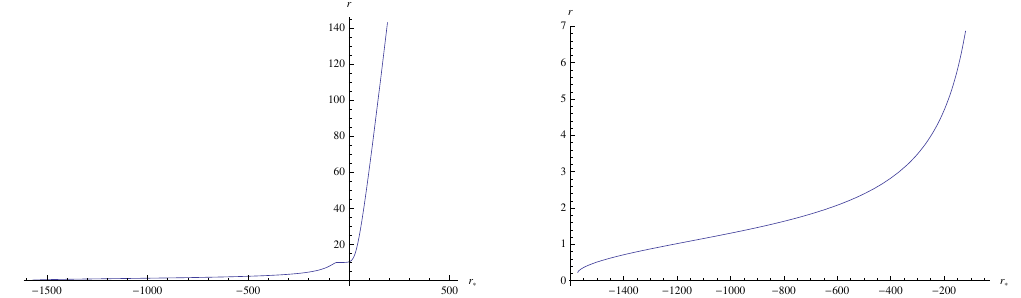
Figure 10 . The radius r for (cid:20)m 0 = 25 : 2, r (cid:3) s = (cid:0) 60 < a (cid:3) , a 0 = 10 and (cid:11) = 0 : 05. The behavior near the neck is the same as (cid:12)gure 6. The radius r increases as r (cid:3) decreases from r (cid:3) = a (cid:3) ’ (cid:0) 56 : 685, but starts to decrease from r (cid:3) ’ (cid:0) 60 : 003. The instability of the numerical analysis appears around r (cid:3) ’ (cid:0) 1571 where the radius is r = r e ’ 0 :